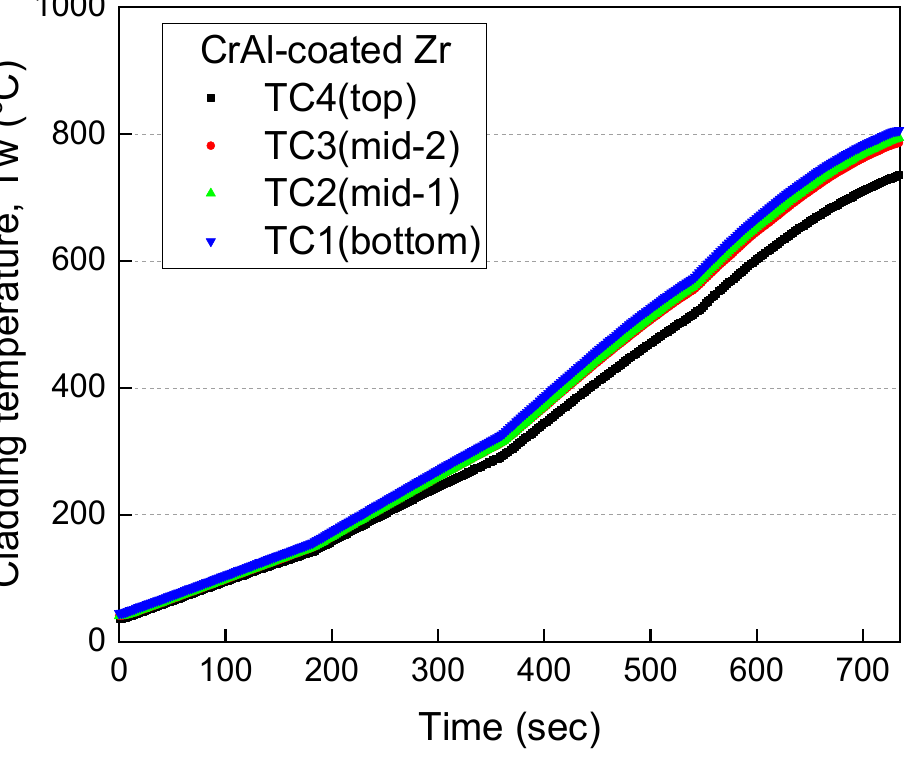
Figure 5. Electrical heat-up of CrAl-coated Zr cladding.